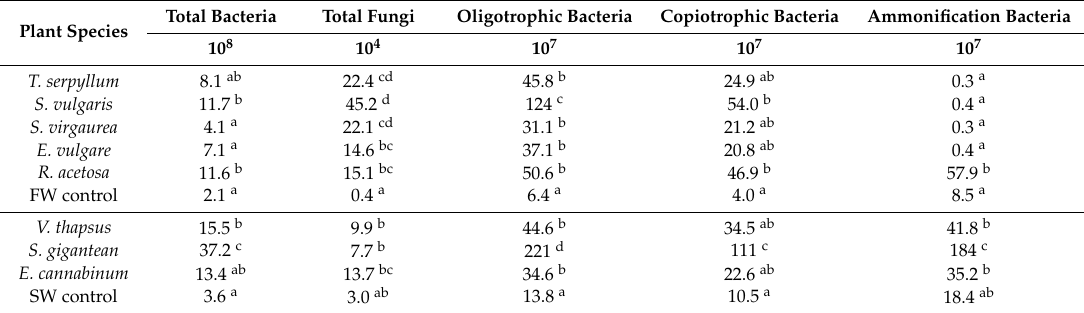
Table 5. Count of cultivable microorganisms in FW and SW soils.